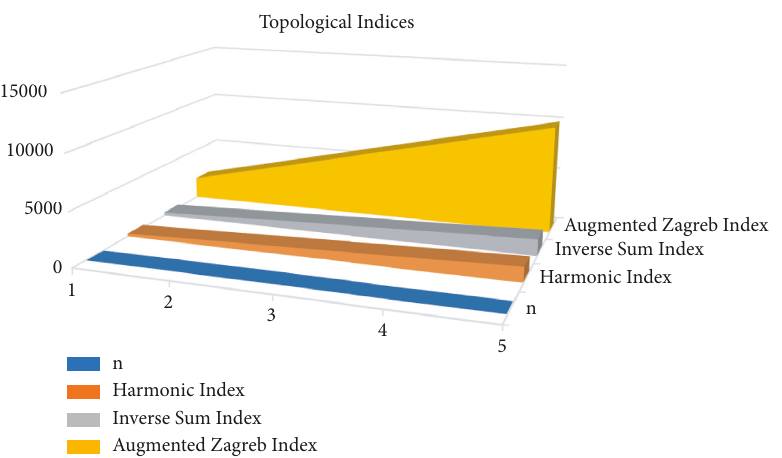
( H ) ,RR ( H ) , for n � 1and α � 2 , 3. α α